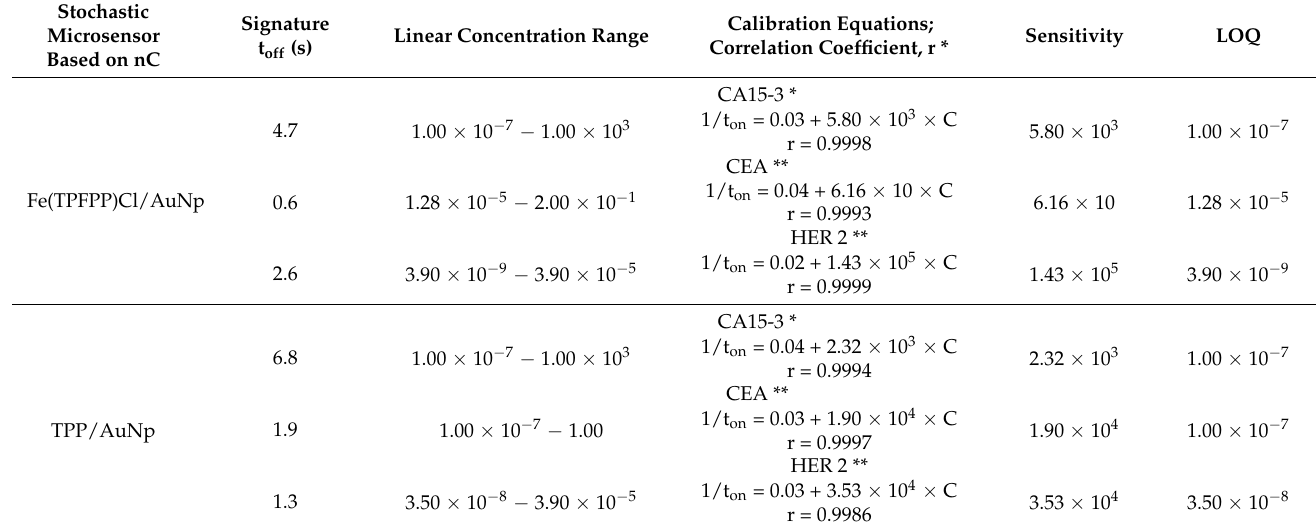
Table 1. Response characteristics of the stochastic sensors used for the assay of CA15-3, CEA and HER